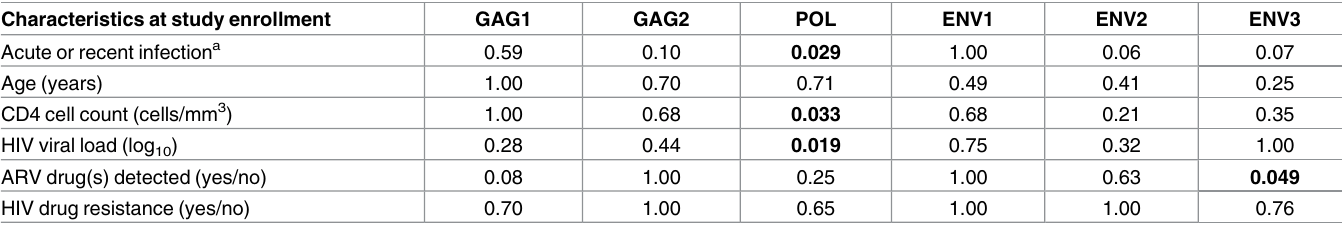
Table 2. Association of HIV diversification with duration of HIV infection and other factors (paired analysis). Characteristics at study